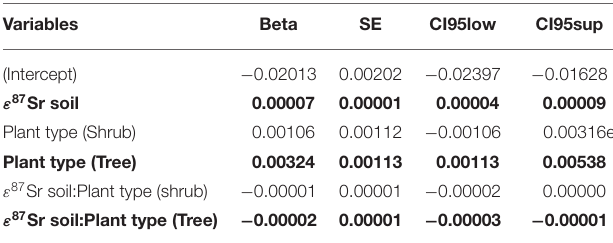
TABLE 4 | Parameters estimates from the mixed-effects model (random factor: sampling site) explaining variation in the 87 Sr/ 86 Sr ratio of biological